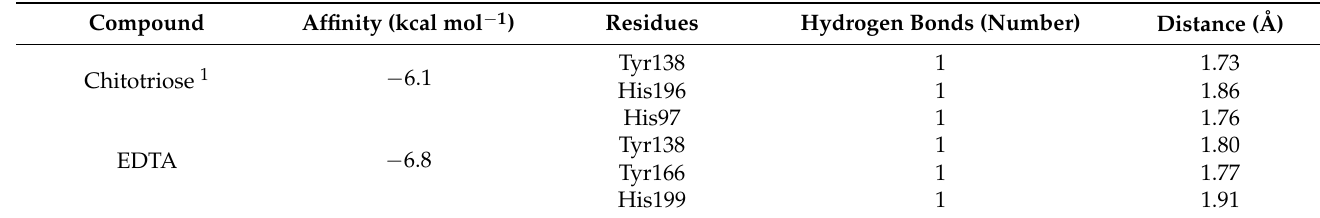
Table 1. Molecular docking analysis of EDTA to a CDA protein from A. nidulans .